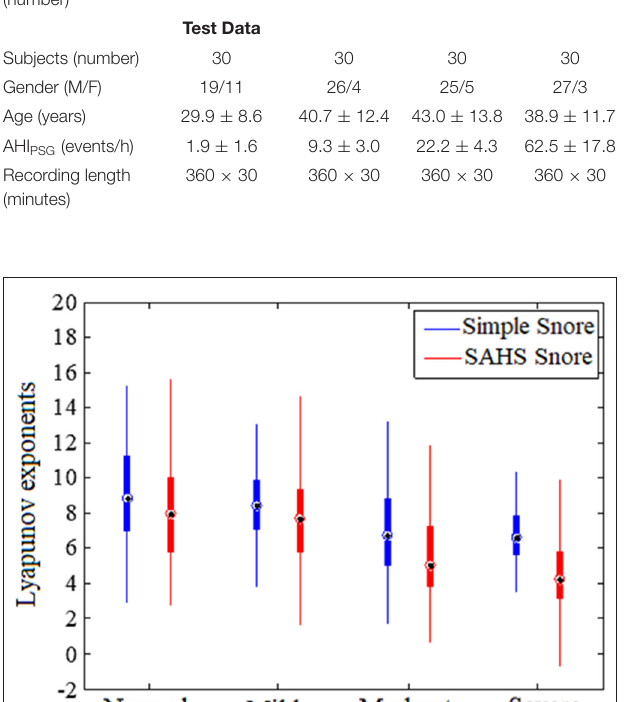
FIGURE 3 | Largest Lyapunov exponents of snore for different SAHS severity levels.